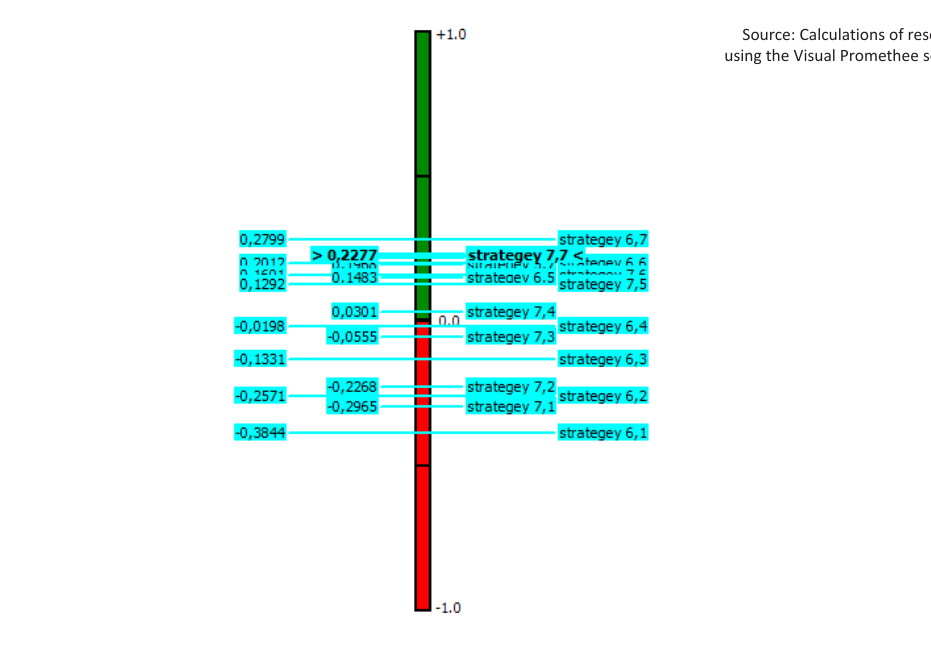
Figure 2. PROMETHEE II at Assumption 1